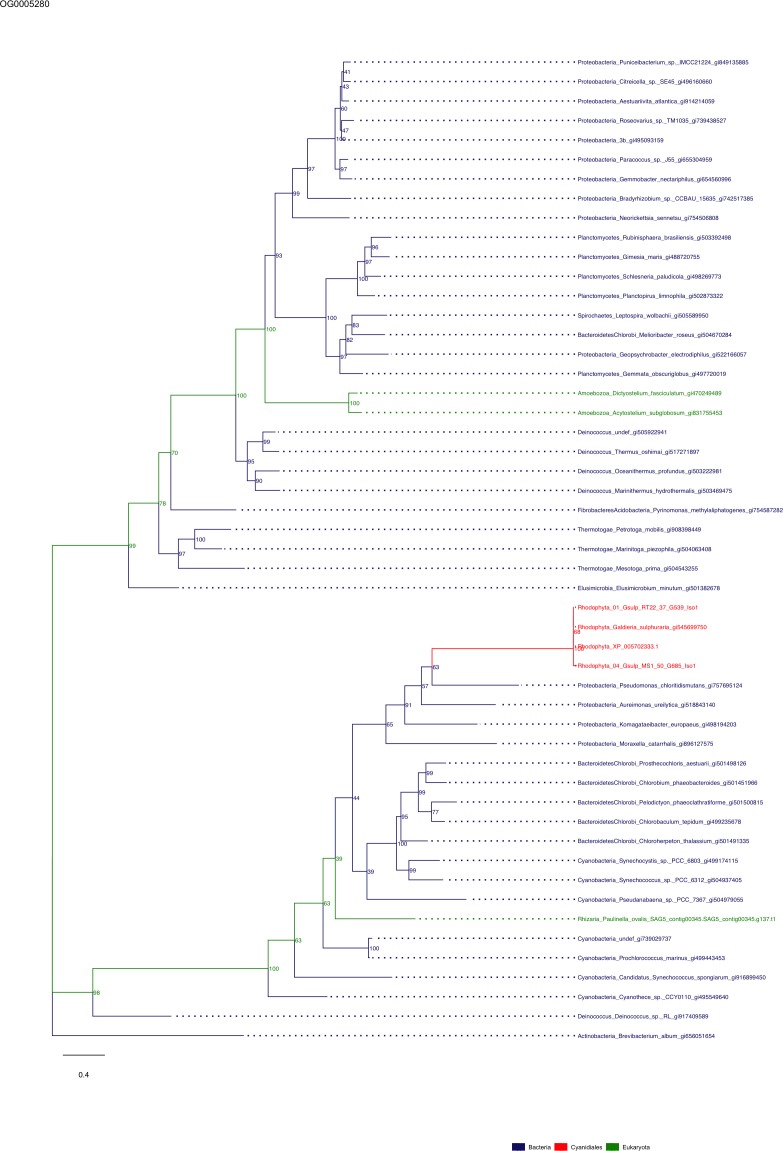
Sequence tree of orthogroup OG0005280.The tree is based on amino acid sequences. Archaea (yellow), Bacteria (blue), Cyanidiales (red), Eukaryotes including other red algae (green). Branches containing Cyanidiales sequences are highlited in red.